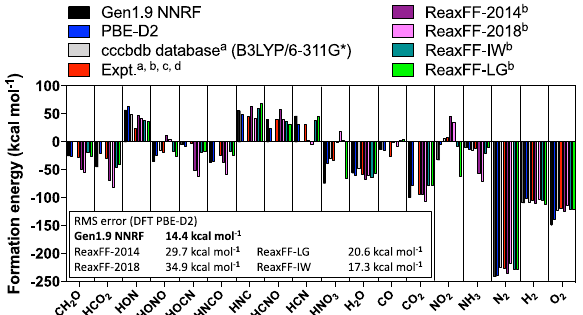
Fig. 4 The formation energy of several intermediate and product molecules. The RMS error of Gen1.9 NNRF and ReaxFFs with respect to DFT in the inset. ( a cccbdb database from ref. 39 , b ReaxFFs formation energies from ref. 3 , c experimental formation energies from NIST database in ref. 76 , d active thermochemical tables in ref. 77